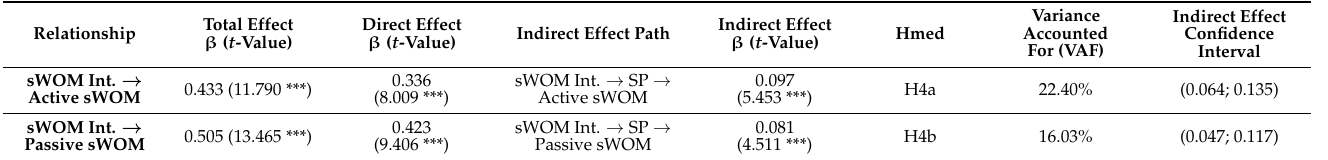
Table 6. Path coefficient and indirect effects for the mediation